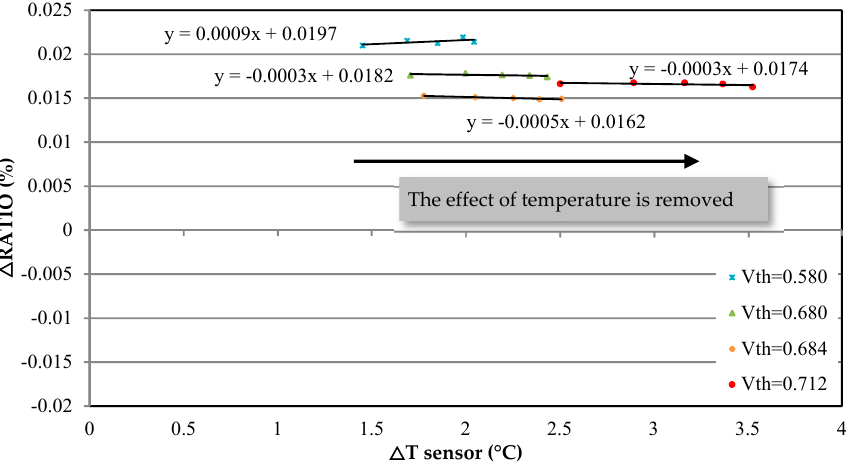
Figure 9. Ratio changes after compensation within 100 min.